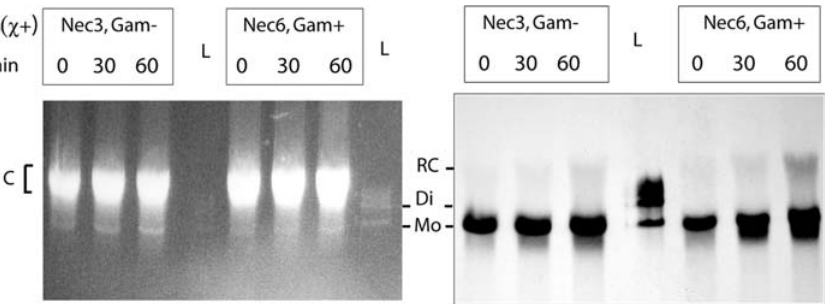
Figure 6. Both l Nec3 and l Nec6 produce rolling circle intermediates. DNA extracted during a kinetics of l infection was loaded on a gel (30 m l), besides a l ladder size marker (shown as L, 1 ng in the middle lane, 10 ng on the right side lane). UV photograph of the gel is shown in the left panel, and Southern blot in the right panel (the last lane was omitted for blotting). Mo, Di and RC: monomer, dimer and rolling-circle forms of l respectively. C: E. coli C600 chromosomal